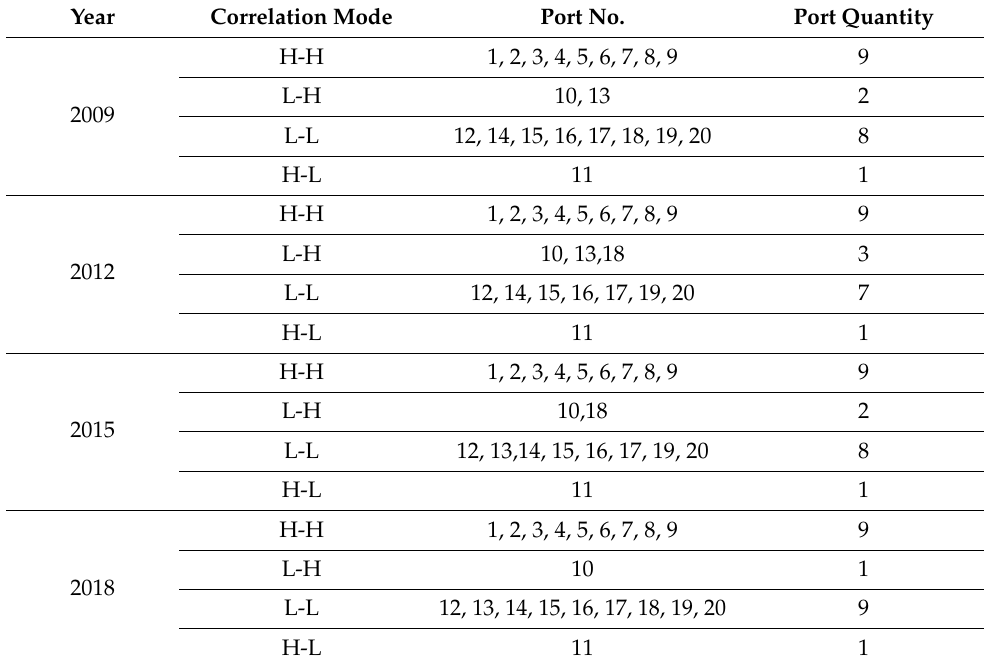
Table 6. Distribution of ports based on their